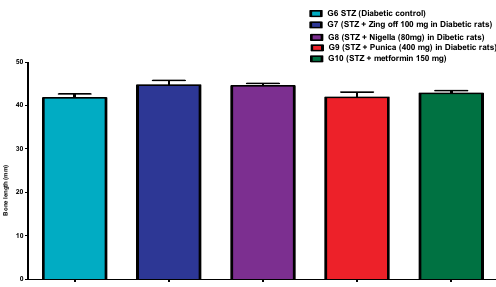
Fig. 1. Comparison of the bone length (mm) in different studied groups.